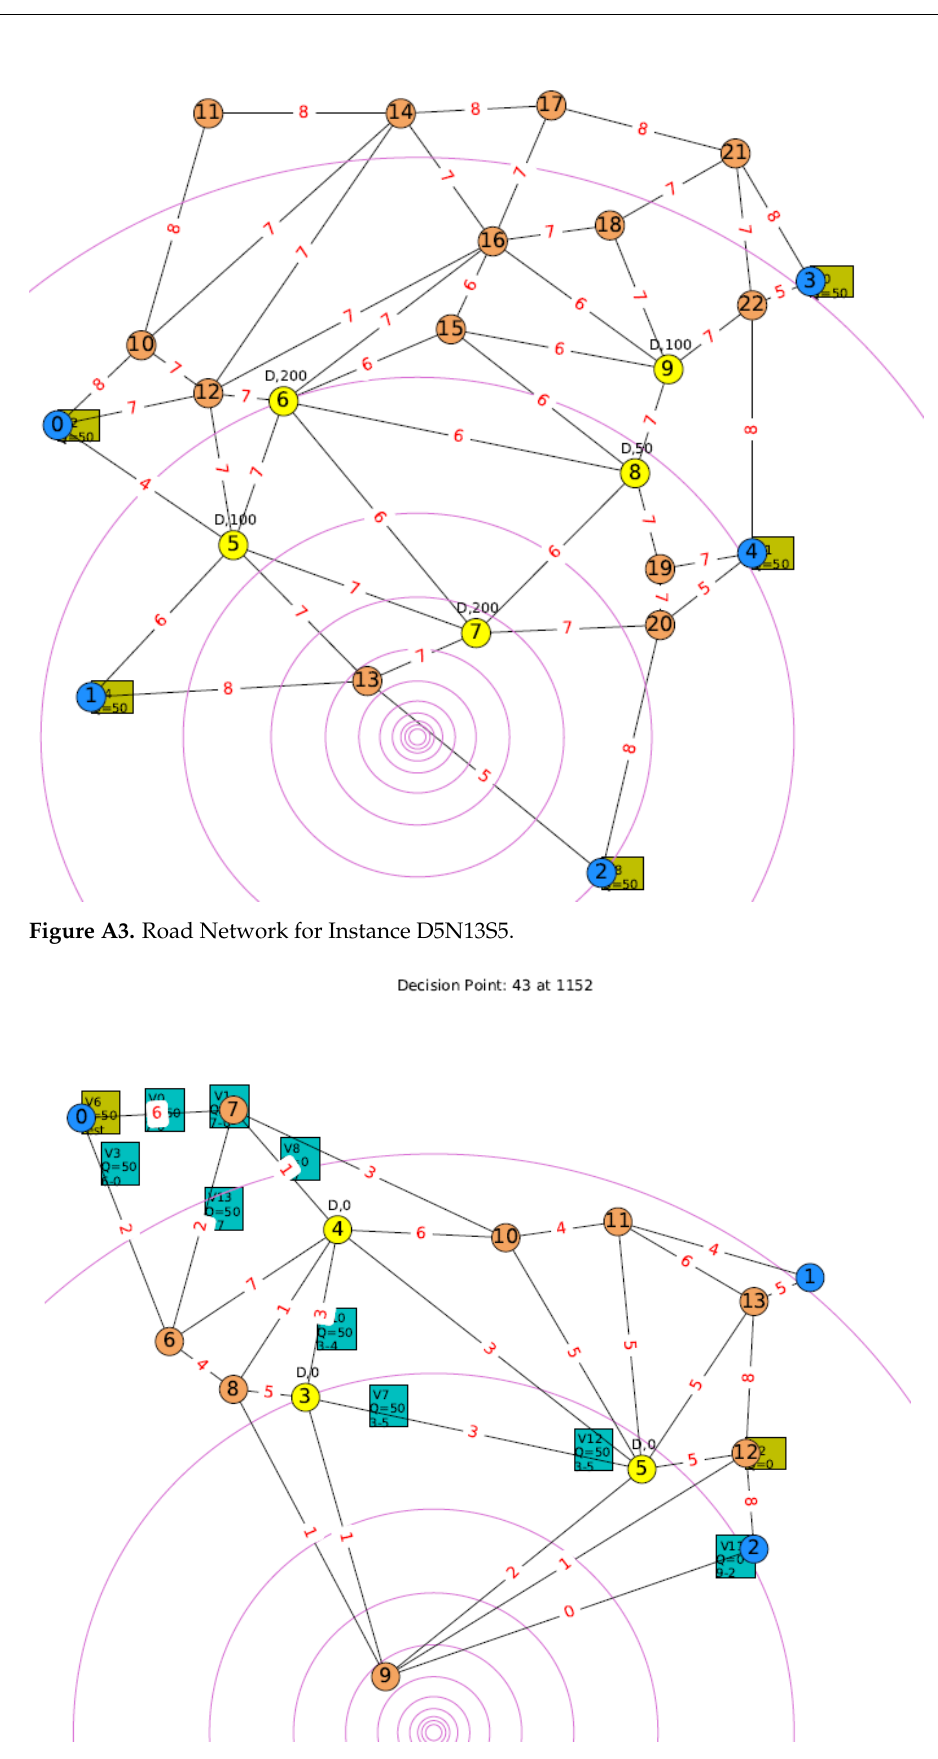
Figure A4. Changes in Road Capacity Over Time in Online Simulation and